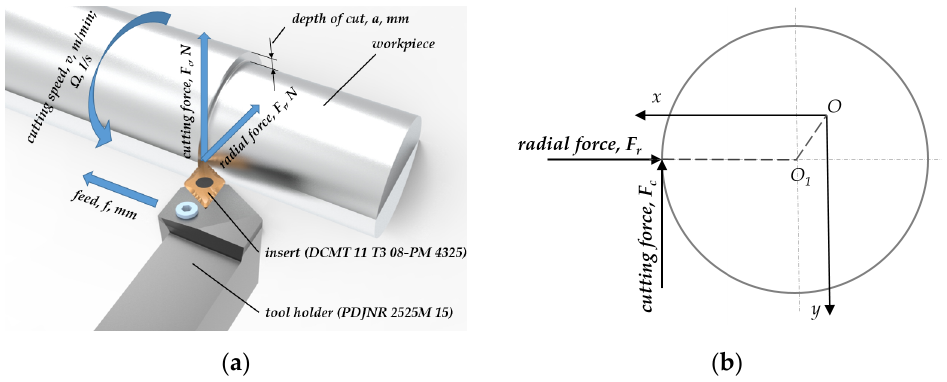
Figure 1. ( a ) Model of the cutting system; ( b ) scheme of the one-mass oscillatory cutting system. On the rotor the cutting force acts. The cutting force has three components in three orthogonal directions: one along the workpiece and two in a plane orthogonal to the length of the